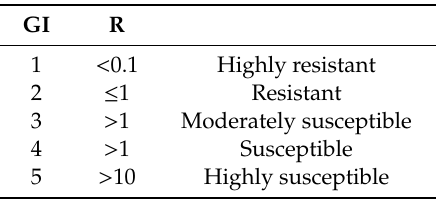
Table 1. Resistance rating scale for Meloidogyne graminicola based on root gall index (GI) and multiplication factor